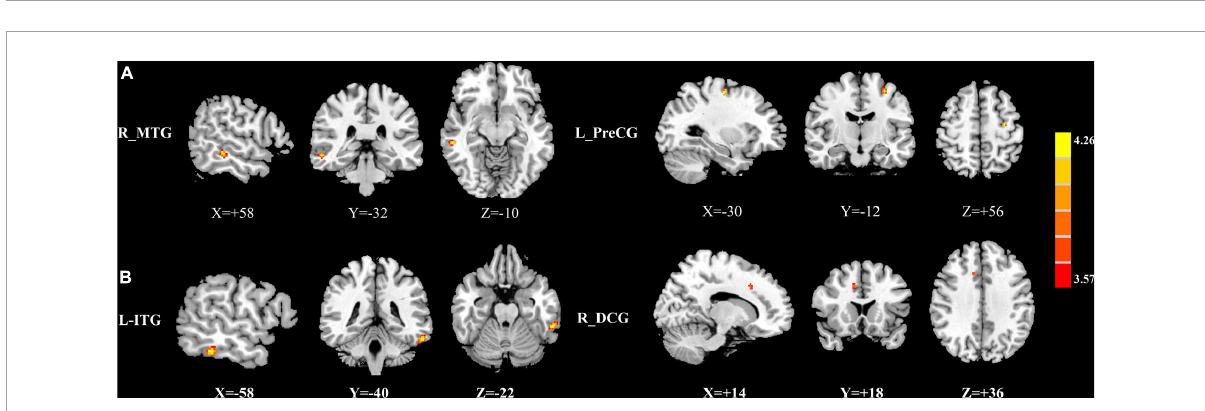
FIGURE3 (A) Brain regions showing significant differences in normalized CBF between men patients and women patients. (B) Brain regions showing significant differences in normalized CBF between men controls and women controls. The warm color represents the significantly increased CBF in the men patients and men controls. CBF, cerebral blood flow, R, right, L, left, MTG, middle temporal gyrus, PreCG, precentral gyrus, ITG, inferior temporal gyrus, DCG, median cingulate and paracingulate gyri.